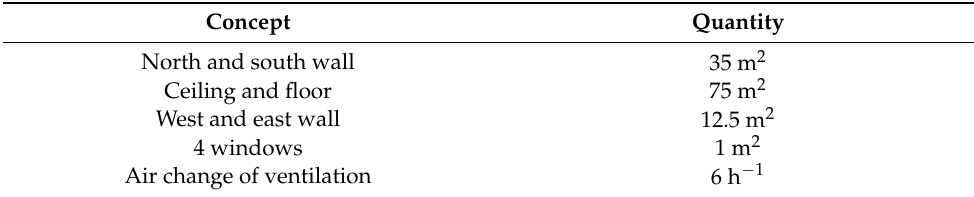
Table 2. Building characteristics.